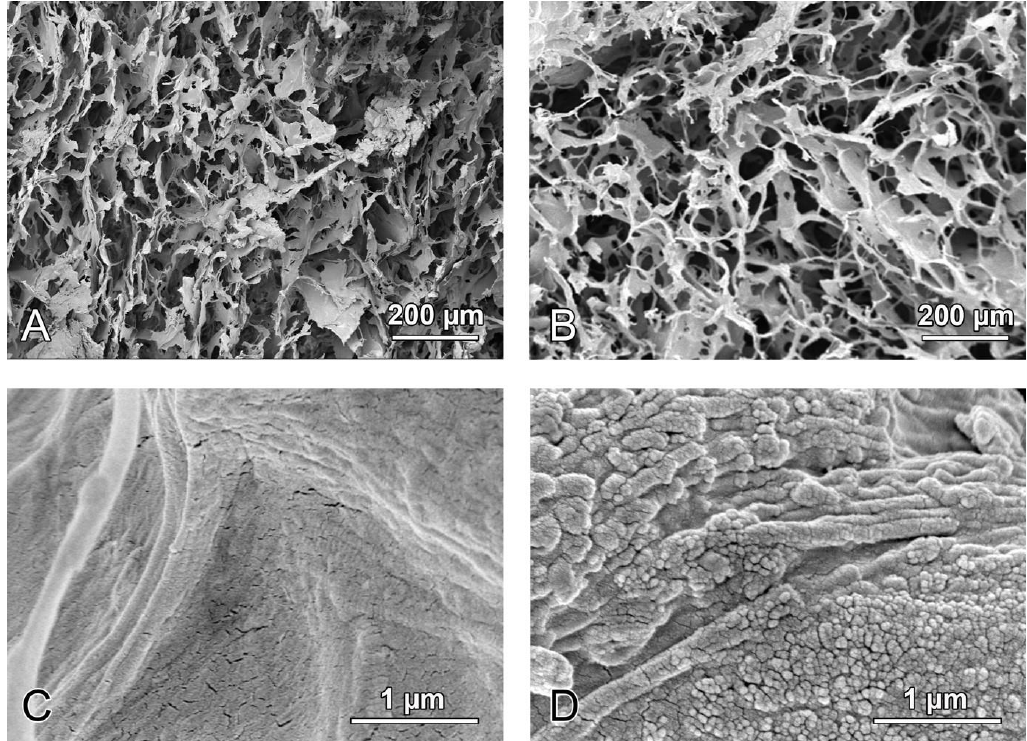
Figure 1. SEM images of the CM, ( A , C ) and mCM ( B , D ). Both CM and mCM showed relatively smooth surface at low magnification because of cross-linking of collagen. The mCM included additional hydroxyapatite particles on the collagen surfaces ( D ).